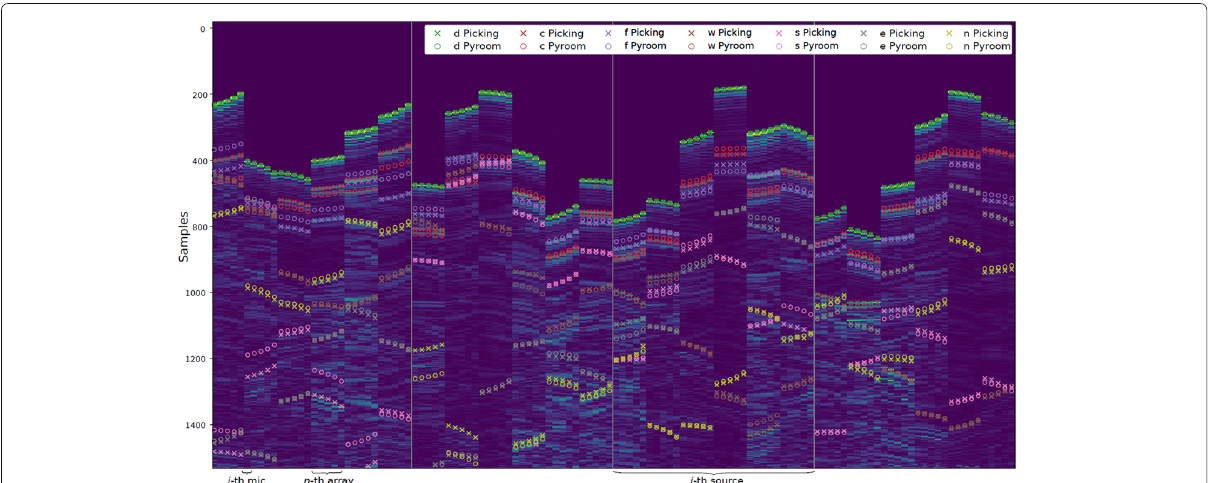
Fig. 6 The RIR “skyline” described in Section 2.3, annotated with observed peaks ( × ) together with their geometrically expected position ( ◦ ) computed with the Pyroomacoustic acoustic simulator. As specified in the legend, markers of different colors are used to indicate the room facets responsible for the reflection: direct path ( d ), ceiling ( c ), floor ( f ), west wall ( w ), ... , north wall ( n